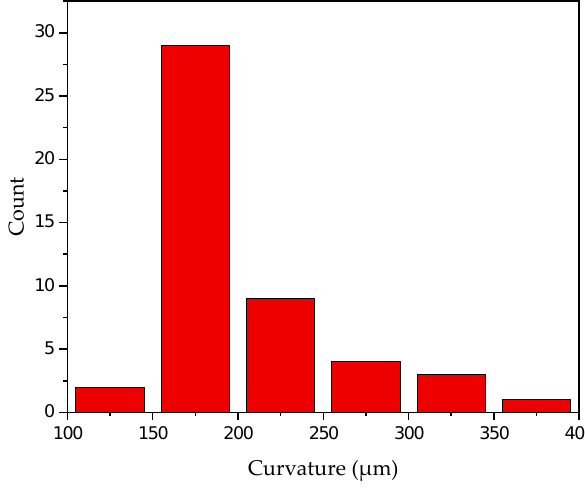
Figure 4. Breakage Distribution of the loop test using glass fibers.